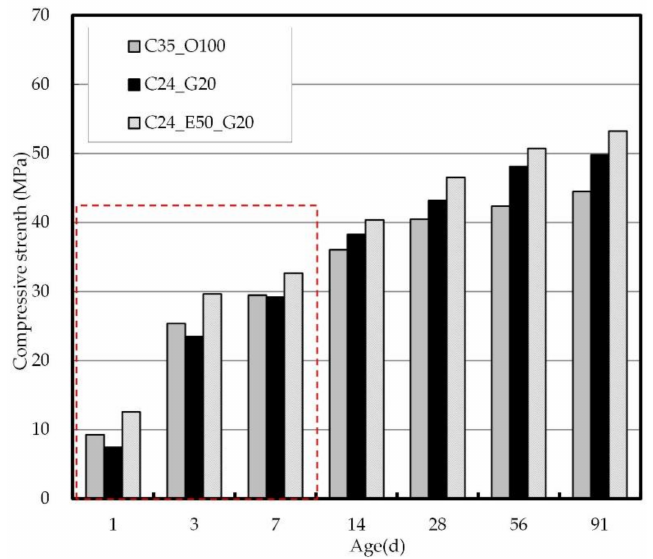
Figure 7. Compressive strength of concrete by